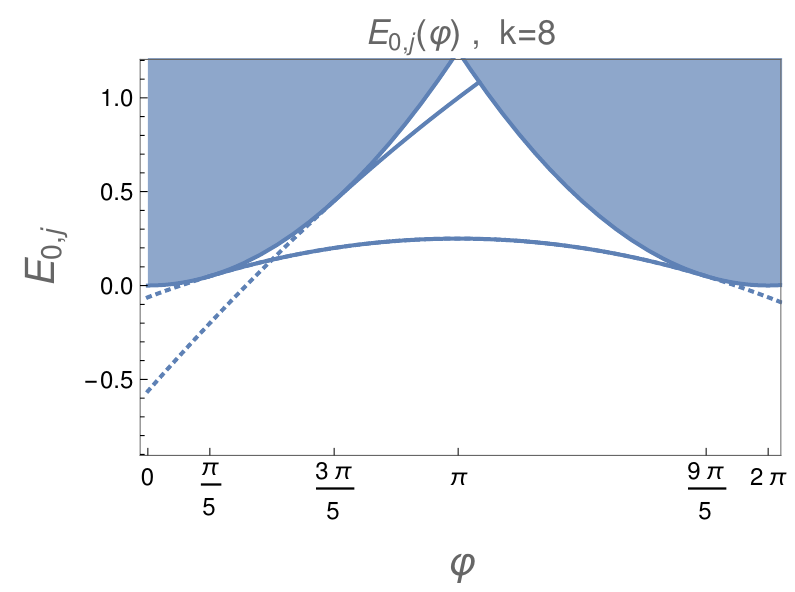
(in 0, j = − 1 ( c − 2 ) m , j m ,0, j 12